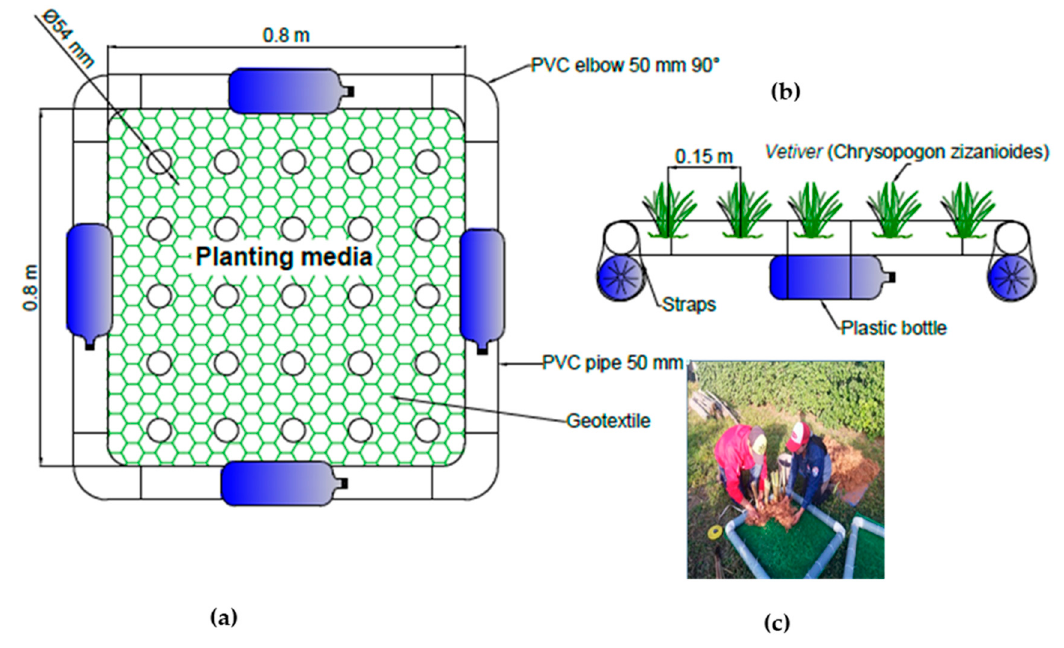
Figure 1. Artificial float island schema: ( a ) top view; ( b ) side view; and ( c ) actual Artificial float island with Vetiver (AFIV).